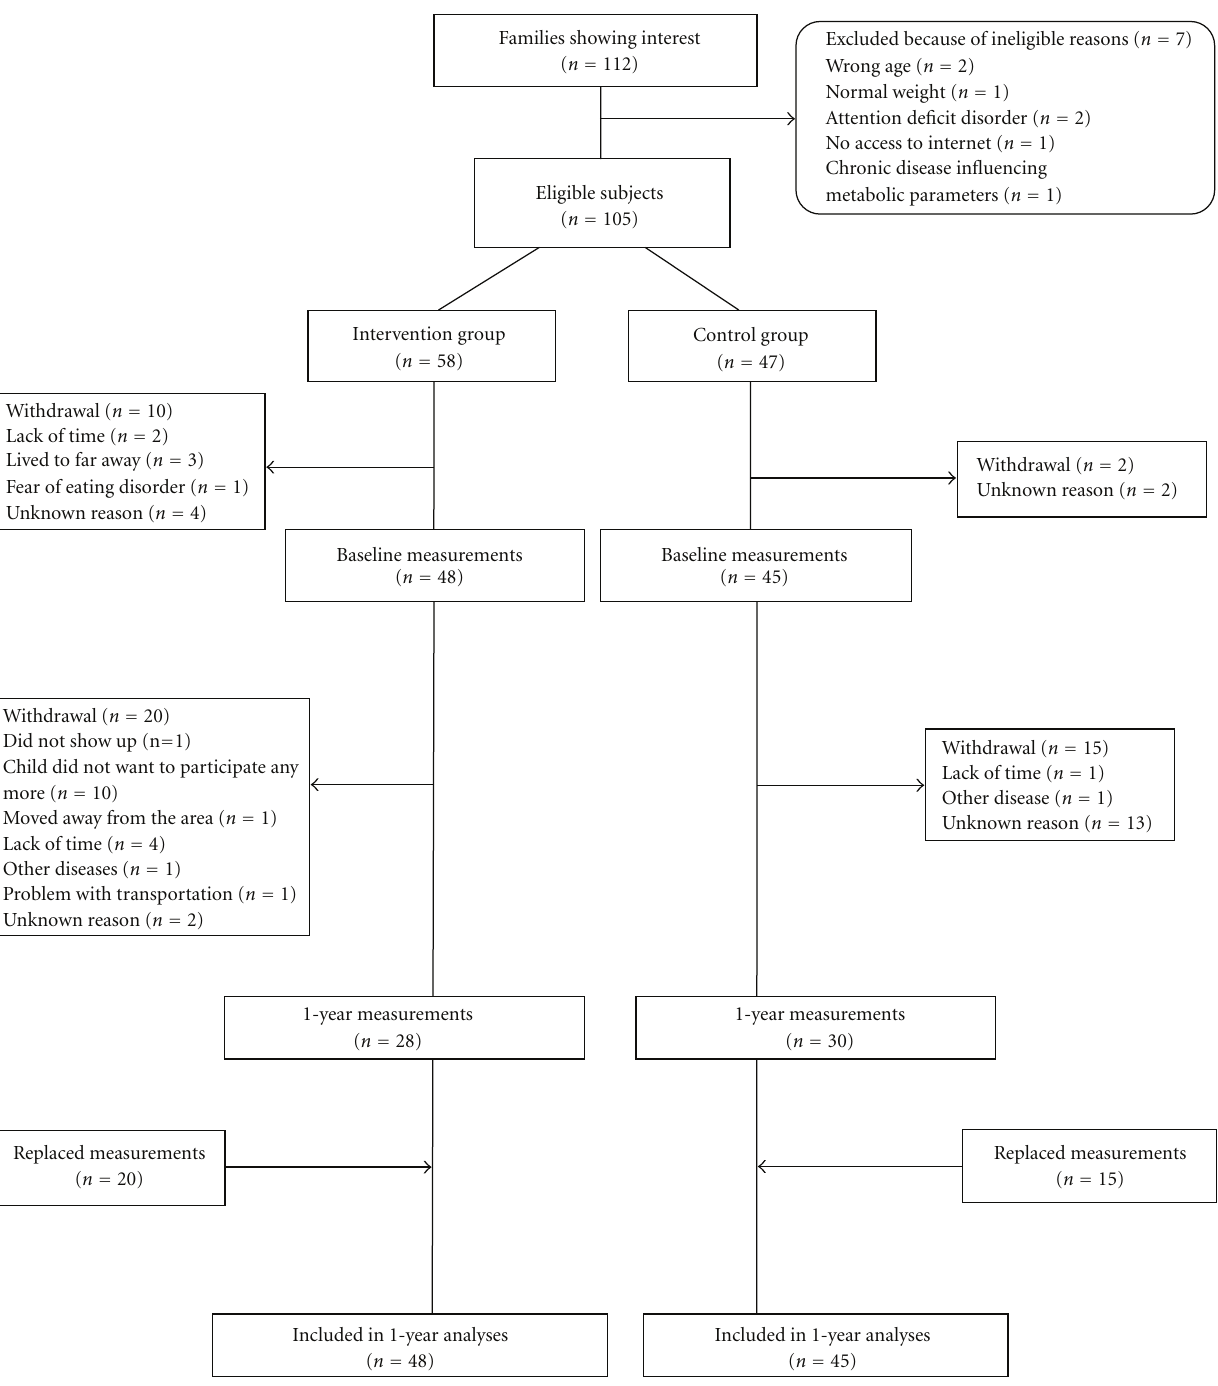
(Hyssna Measuring Equipment AB, Sweden), and weight was measured to the nearest 0.1 kg with an electronic scale (AJ Medical, Sweden). The main outcome of the study, BMI, was calculated as weight (kg)/height (m) 2 and converted to BMI z -scores by using both US reference data [25] and a Swedish reference dataset [26]. Children were classified as normal